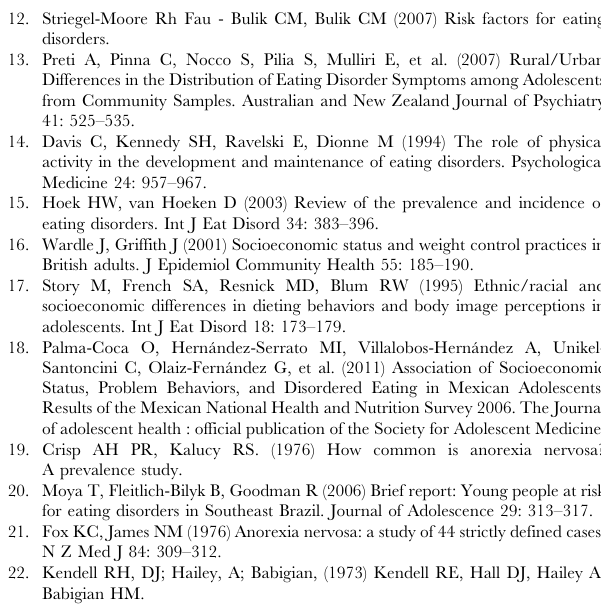
Table S1 The correlation between adolescents-reported household economic status and parents-reported annual household income in sub-samples (n= 50). 1 1: lowest 1,